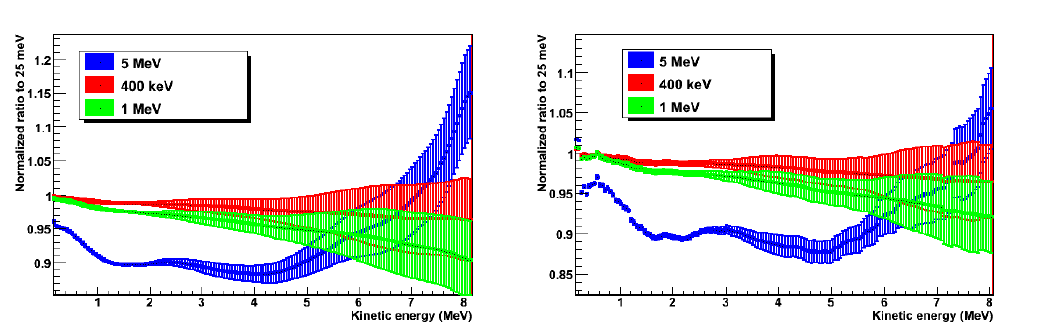
Figure 5. Normalized ratio of the calculated energy spectra for 235 U using 500 keV, 1 MeV and 5 MeV incident neutron cumulative fission yields from GEFY-5.3 to the energy spectra using the 25.3 meV fission yields for electrons (left) and anti-neutrinos (right). The uncertainties are propagated from nuclear data